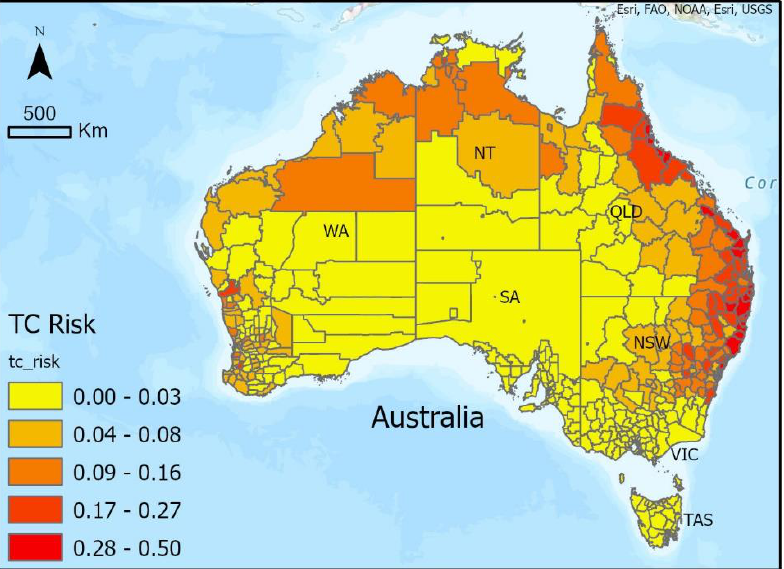
Figure 11. Combined multi-hazard risk calculated by equally weighting four hazard-specific risk maps.